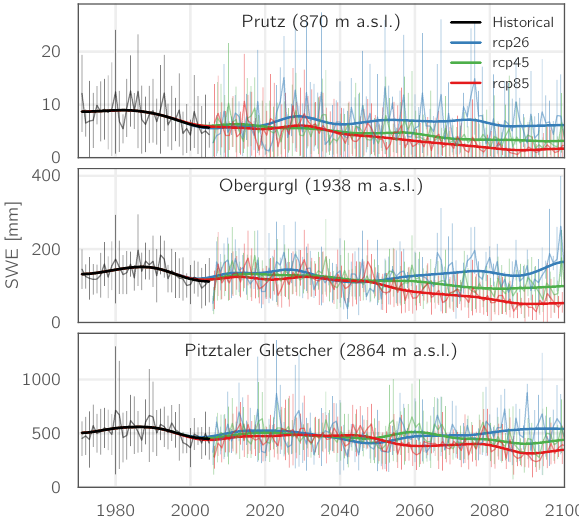
Figure 8. Evolution of mean annual SWE for the stations Prutz, Obergurgl, and Pitztaler Gletscher as simulated using the EURO- CORDEX scenarios for the RCPs2.6, 4.5, and 8.5. Thin lines and error bars indicate the multi-model mean and standard deviation, respectively, while the thick lines show the 5-year Gaussian low- pass filtered multi-model mean.